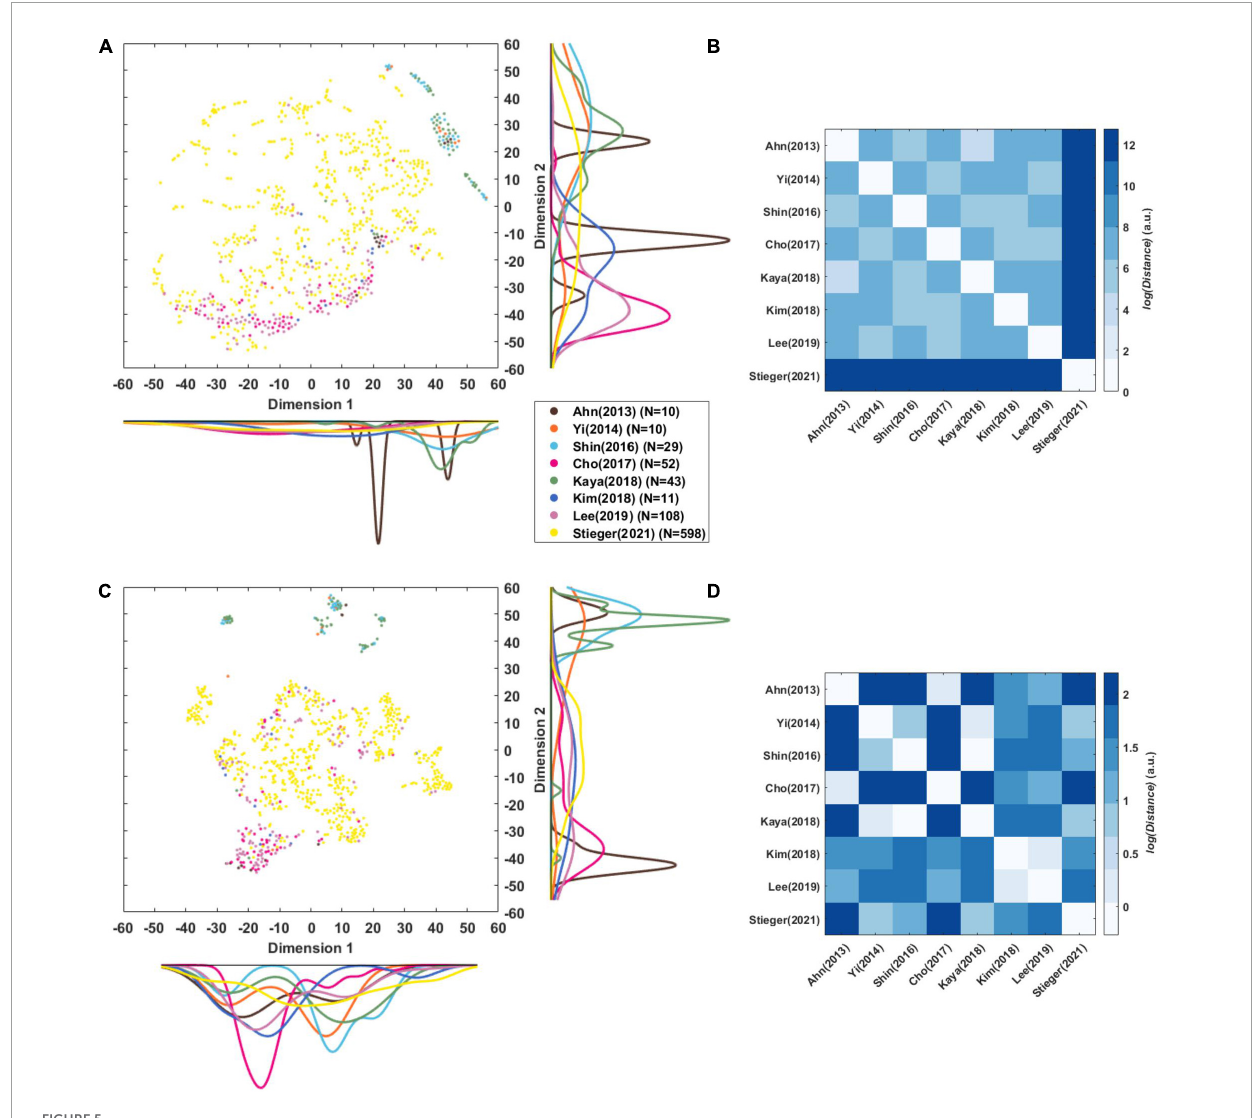
FIGURE5 Visualization of CSP features. (A,C) t-SNE maps of eight-dimensional raw CSP features and normalized CSP features of each subject that was compressed into a two-dimensional space. The color lines along each axis display the marginal distribution of each dimension computed by Kernel Density Estimation. (B,D) Euclidean distance (in arbitrary units) among centroids of datasets in the eight-dimensional raw CSP features’ and normalized CSP feature’